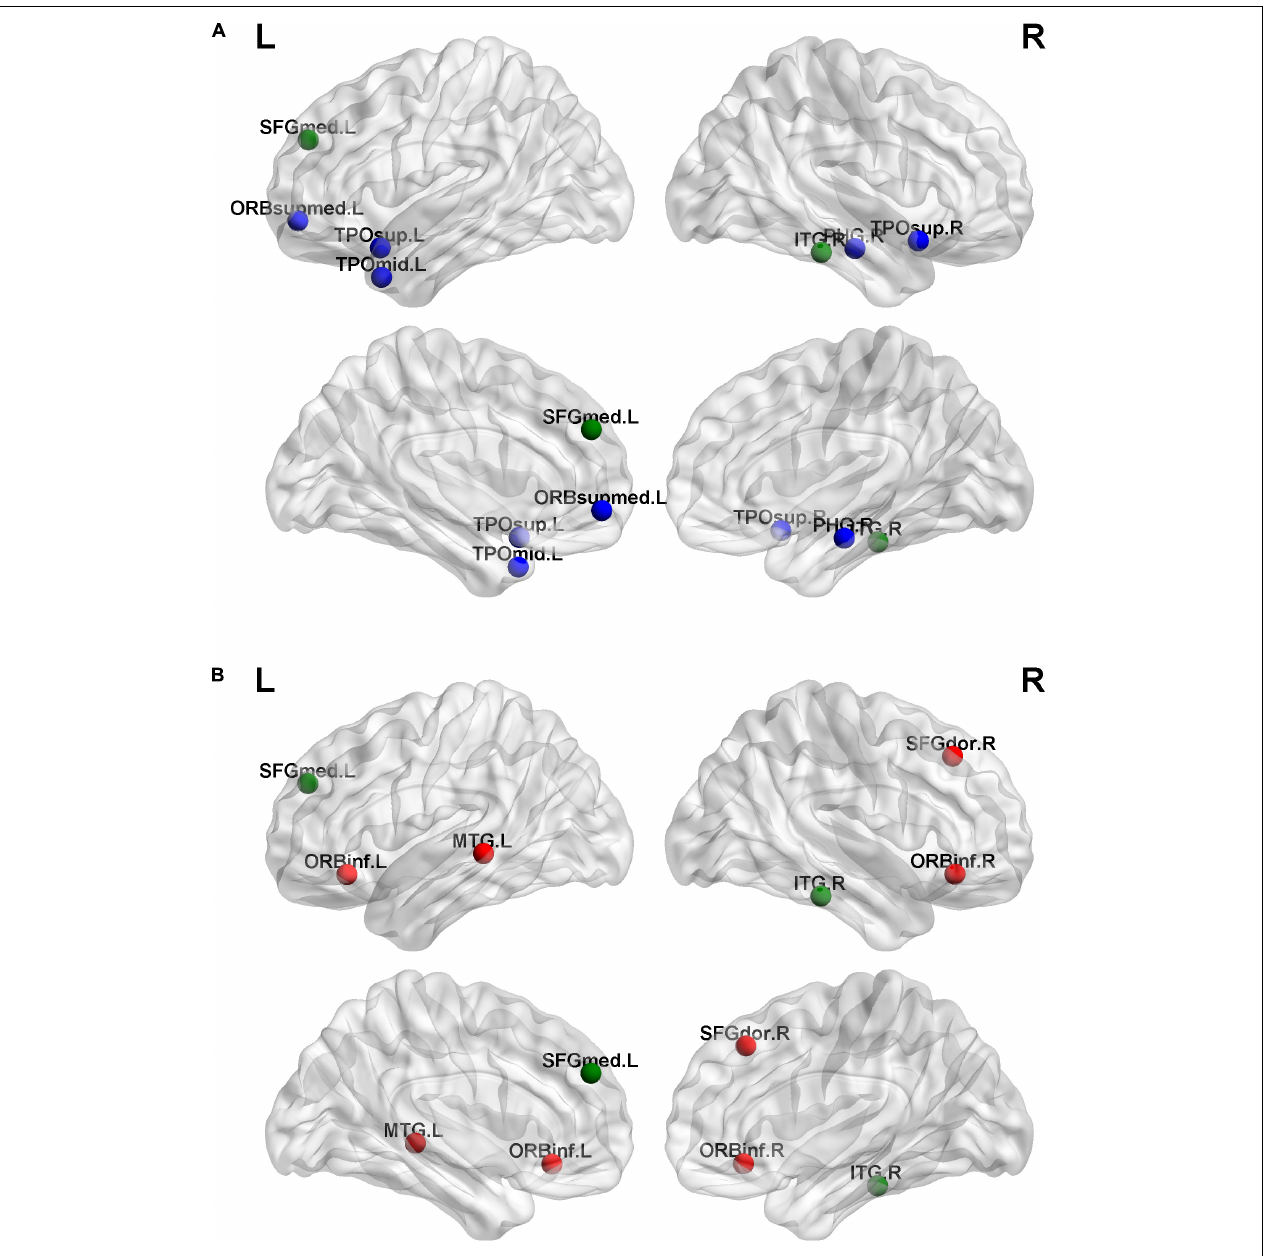
FIGURE 4 | Hubs for brain functional networks in normal-hearing (NH) group (A) and sensorineural hearing loss (SNHL) group (B) . The hubs identified in both groups are shown in green color. While the hubs for the SNHL group only are present with red color, the hubs for the NH group only are shown in blue